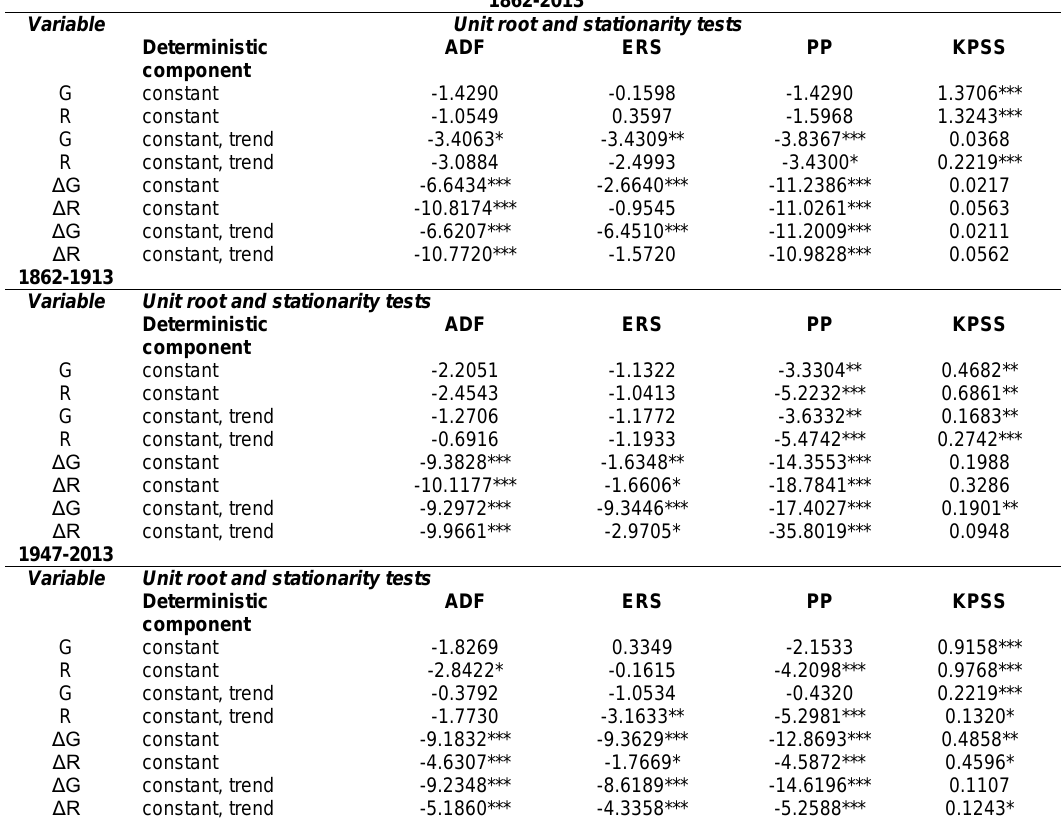
Table 2 . Results for unit roots and stationarity